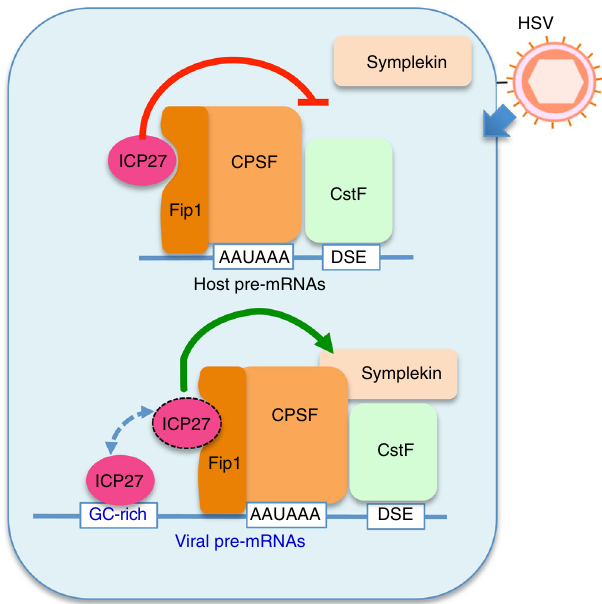
Fig. 7 A model for ICP27-mediated regulation of mRNA 3 ′ processing. In HSV-1-infected cells, ICP27 interacts with CPSF and induces the assembly of an aberrant 3 ′ processing complex. At viral PASs or host PASs that have GC-rich upstream sequences (UPS), ICP27 binds to these UPS sequences and promotes recruitment of CPSF, thereby activating mRNA 3 ′ processing. The transition of ICP27 between the CPSF-bound and UPS RNA-bound states is illustrated by a dotted